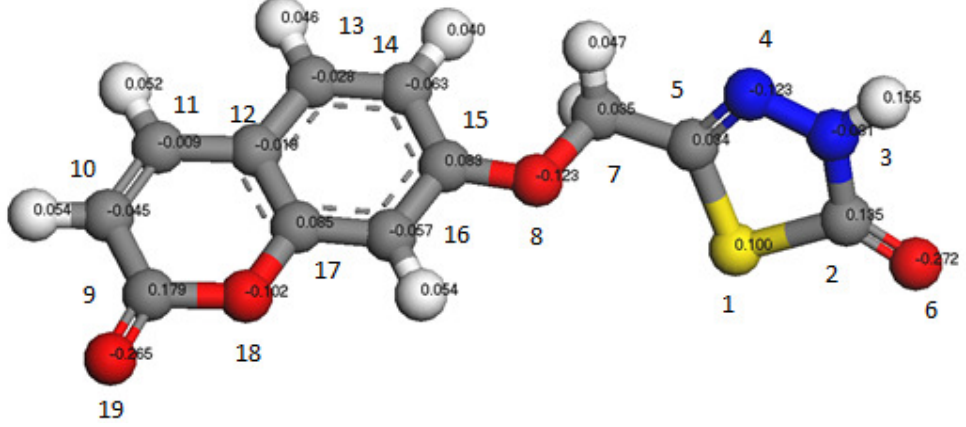
Figure 1. 3d-geometrical structure for compound 5 .